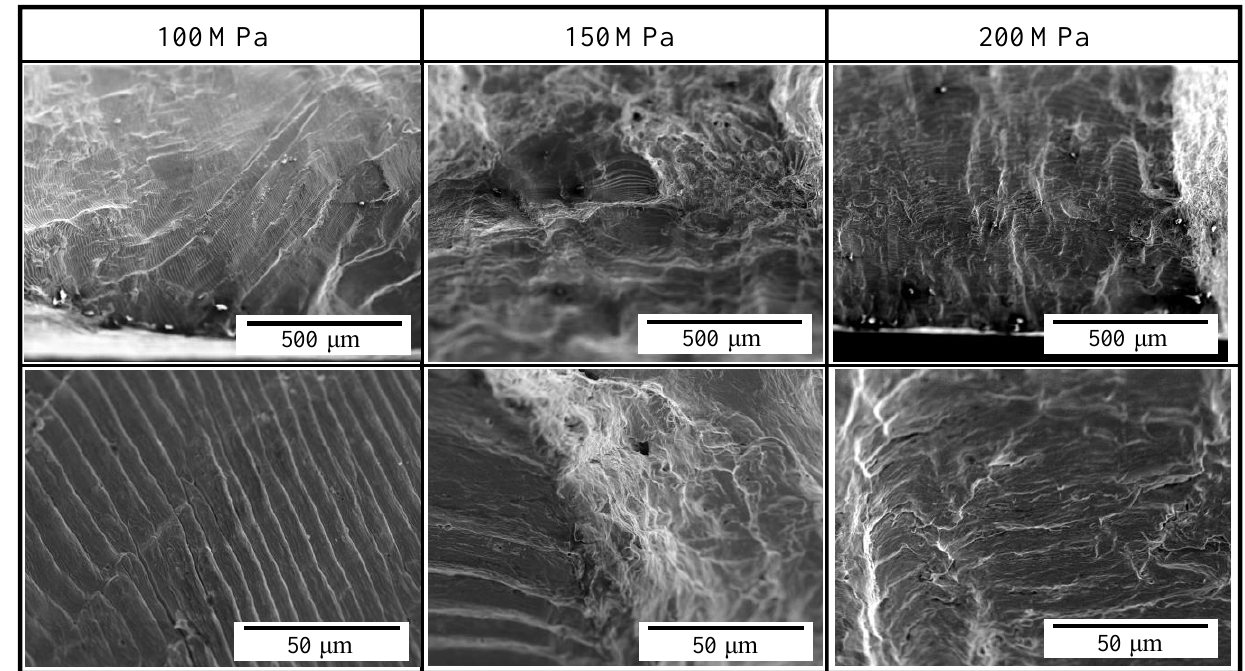
Figure 6. Secondary electron images of fracture surfaces of untreated specimens after the low cycle fatigue test. Bottom images are magnified images of upper ones.